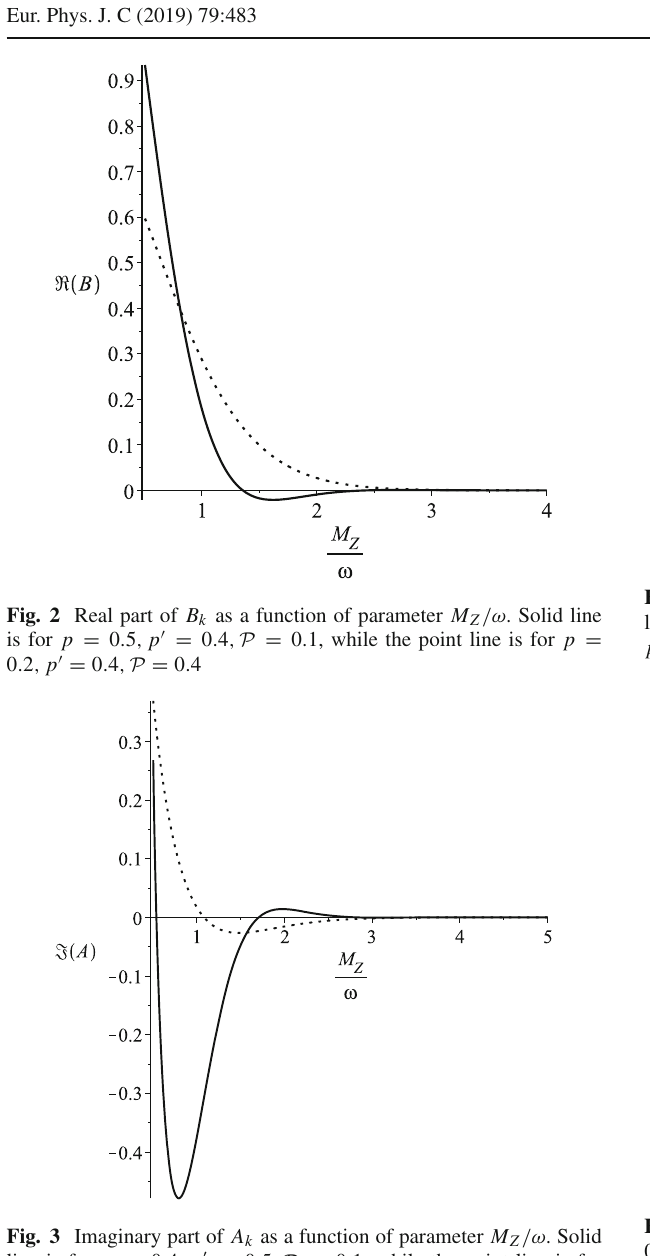
Fig. 3 Imaginary part of A k as a function of parameter M Z /ω . Solid line is for p = 0 . 4 , p (cid:11) = 0 . 5 , P = 0 . 1, while the point line is for p = 0 . 2 , p (cid:11) = 0 . 4 , P = 0 . 4